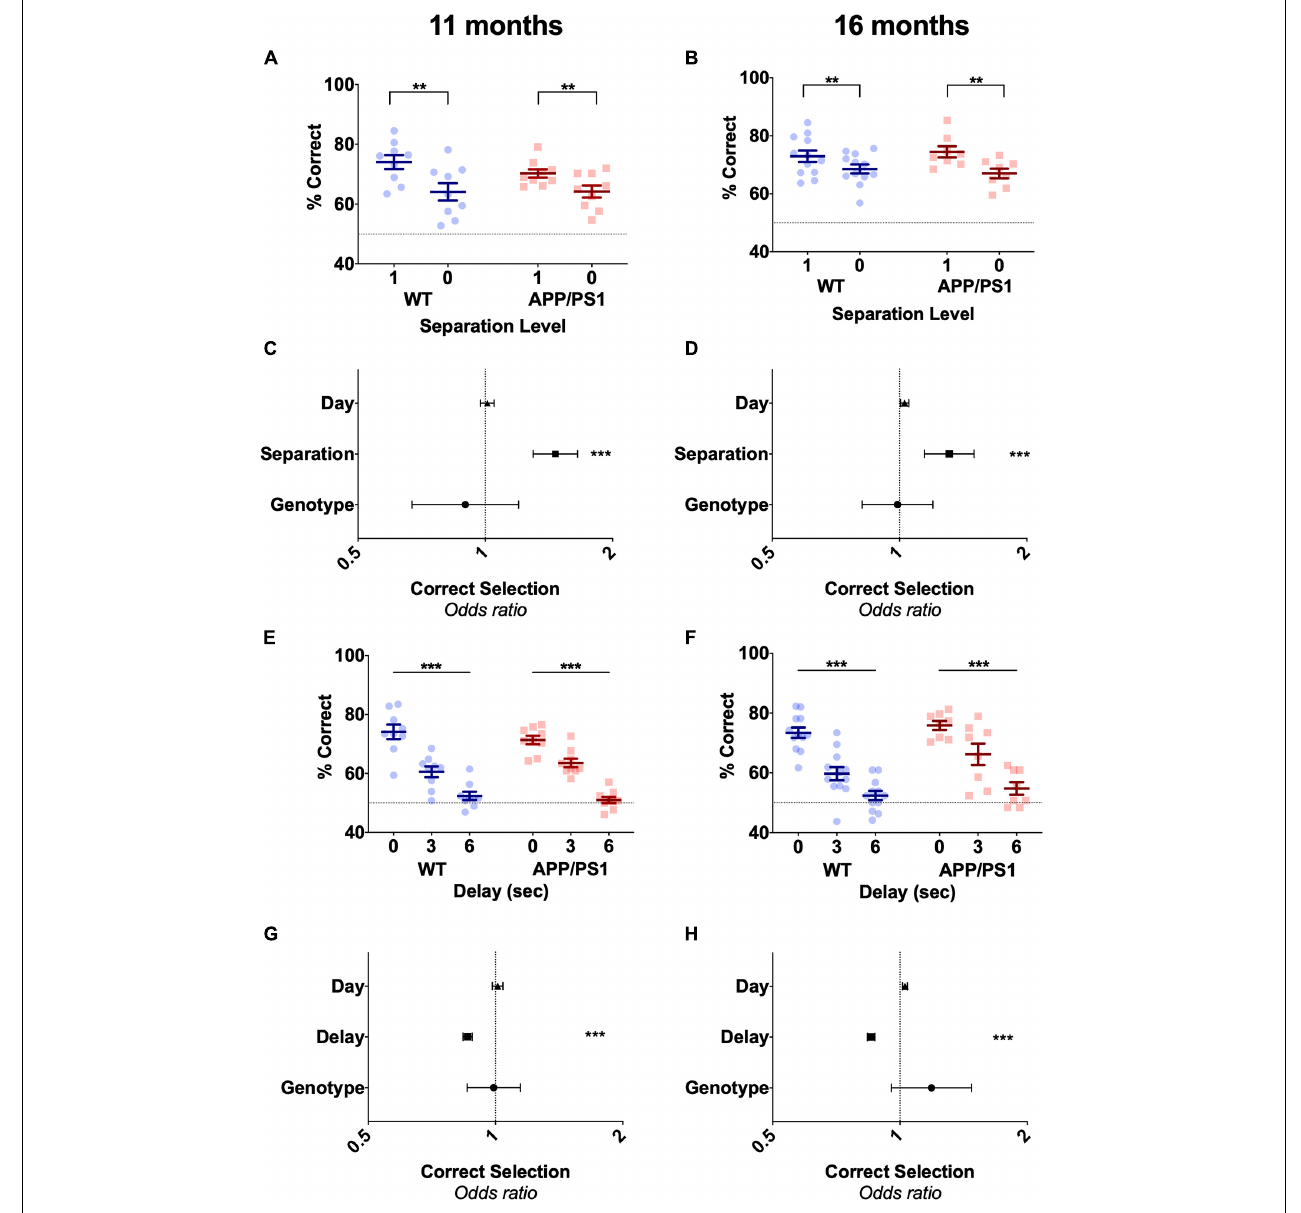
FIGURE 3 | Both 11-month-old and 16-month-old APP/PS1 mice do not show pattern separation or spatial working memory deficits. (A) Accuracy on both S1 and S0 trials in 11-month-old mice or (B) 16-month-old mice was unaffected by genotype but decreased by separation level in both groups. (C) Odds of correct selection was unaffected by day and genotype but increased by increasing separation level in 11-month-old mice and (D) 16-month-old mice. (E) Similarly, genotype had no effect on accuracy over a 0, 3, and 6-s delay in 11-month-old mice or (F) 16-month-old mice, although longer delays significantly decreased accuracy in both ages. (G) Odds of correct selection was unaffected by day and genotype but decreased by delay in 11-month-old mice and (H) 16-month-old mice. (A,B,E,F) Are presented as mean ± SEM with individual animals as dots. (C,D,G,H) Are the effect size ± 95% CI, showing the effect of genotype, day and separation level or delay on odds of correct selection. Dotted line in (A,B,E,F) represents chance performance (50%). ** p < 0.01; *** p <